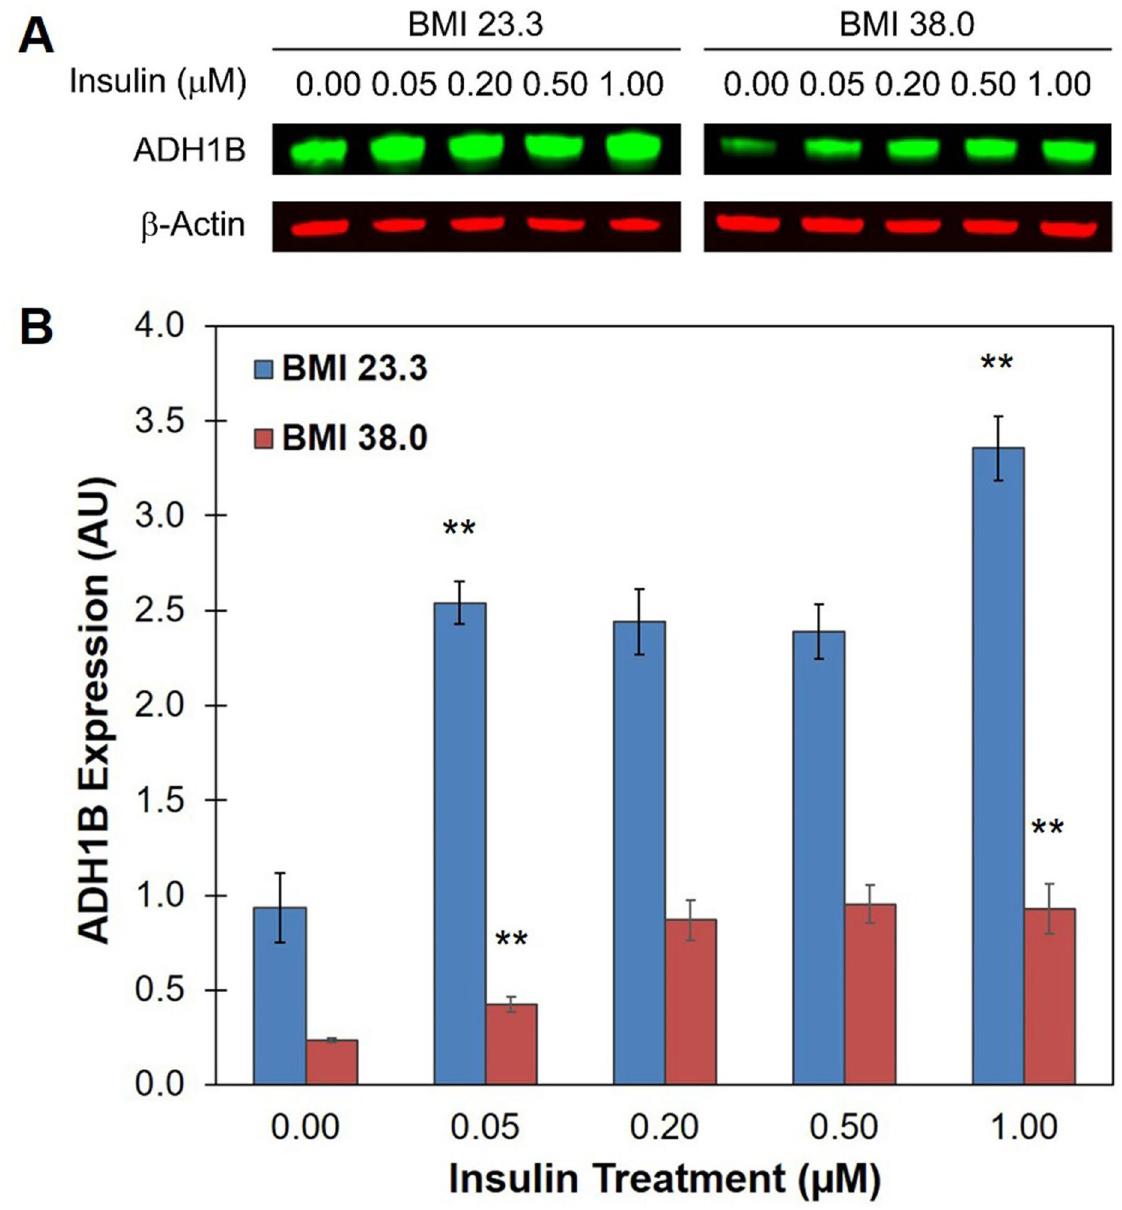
Figure 5. Insulin promotes expression of ADH1B in lean and obese adipocytes. ( A ) Representative composite immunoblot image of cell lysates from lean (BMI < 28 kg m −2 ) and obese (BMI ≥ 30 kg m −2 ) adipocytes following treatment with increasing doses of insulin. Cells were starved for 12 h and then treated with the indicated dose of insulin for 1 h. Total protein was isolated, resolved by SDS-PAGE, and immunoblotted with antibodies specific for ADH1B and β-Actin loading control. Full length blot is presented in Supplementary Figure S14. ( B ) Quantitative analysis of ADH1B expression. Western blot analysis was performed in quadruplicate. Fluorescence intensity was quantified and normalized to β-Actin control. Data is presented as the mean ± s.e.m. AU, Arbitrary Units; **P < ADH1B plays a functional role in the cell response to insulin. Many factors affect enzyme activity including enzyme concentration and stability, substrate concentration and availability, presence of inhibitors and cellular conditions. To confirm insulin-mediated stimulation of ADH1B protein expression results in increased ADH1B enzymatic activity, we measured alcohol dehydrogenase activity with a colorimetric assay that utilizes isopropanol as a substrate. The results revealed that treatment of lean adipocytes with 1.0 µM insulin for 1 h stimulated a highly significant (P = 0.008) ~ threefold increase in ADH1B activity compared to untreated control, indicating insulin-induced ADH1B expression results in a proportional increase in activity (Fig. 7). To discover a potential role for insulin-induced ADH1B activity in adipocytes, we used ADH1B-specific pooled siRNA to silence ADH1B protein expression in cultured mature adipocytes. We confirmed the efficacy and specificity of siRNA knockdown in adipocytes by standard Western blot analysis (Supplementary Fig. S12).